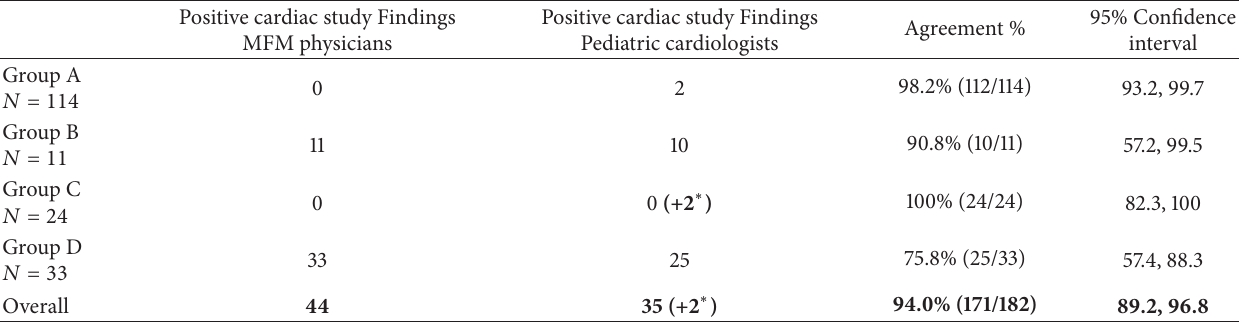
Table 2: Comparison of fetuses with cardiac anomaly found by MFM physician versus pediatric cardiologist for Groups A through D ( 𝑛 = 182